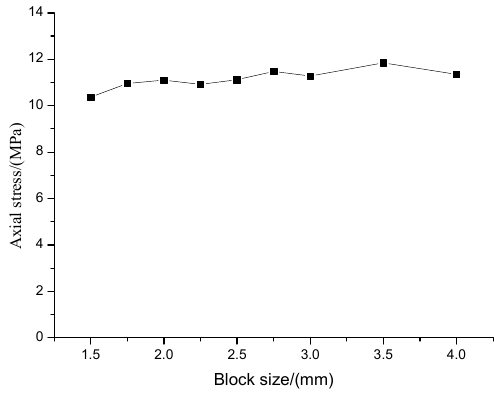
Figure 5. Effect of block size on uniaxial compression strength (UCS).